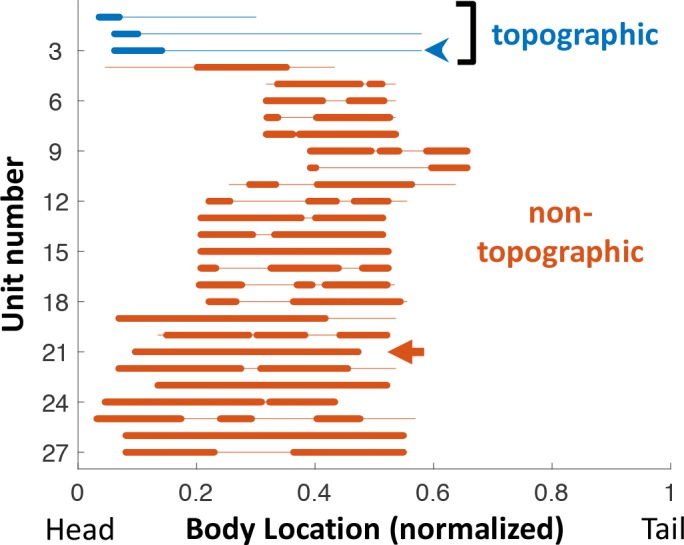
Receptive fields across the PG population.Each line depicts the RF of one unit tested with the RF sampling protocol. Location along the body was normalized to total fish length. Thin line: range sampled (affected by the fish size and position within the tank); The hindmost third of the body was never sampled, as it has a very low density of electroreceptors (Carr et al., 1982) and is also too close to the electric organ. Thick line: positions in which unit’s response was statistically significant (see Materials and methods). Blue arrowhead: unit depicted in Figure 2A. Red arrow: unit depicted in Figure 2B. Note that for most units the RF extends beyond the sampled range. Also note that all three topographic units had RF at the rostral edge of the head, where electroreceptor density is maximal (Carr et al., 1982).